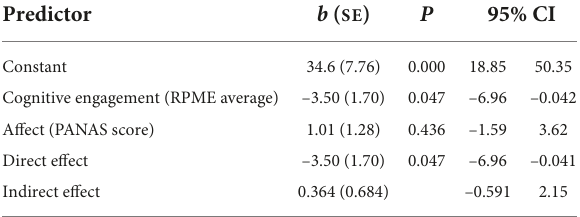
TABLE 7 Mediation model for the interaction between cognitive engagement and affect on inhibition performance.